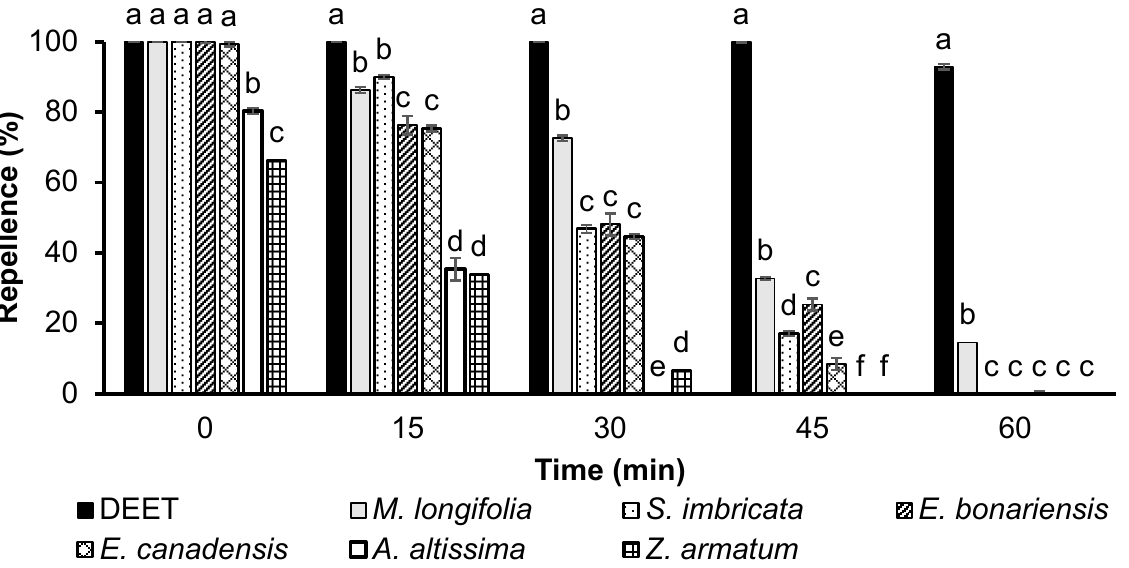
Figure 3. Time-based repellency of DEET and essential oils at a dose of 166.5 µ g/cm 2 against Ae. aegypti . Bars having different letters depict significant differences ( p < 0.05) among the repellency of different tested substances at different periods of post-treatment that were compared for each period independently by ANOVA post hoc Tukey test. Error bars denote the standard error (n = 5).